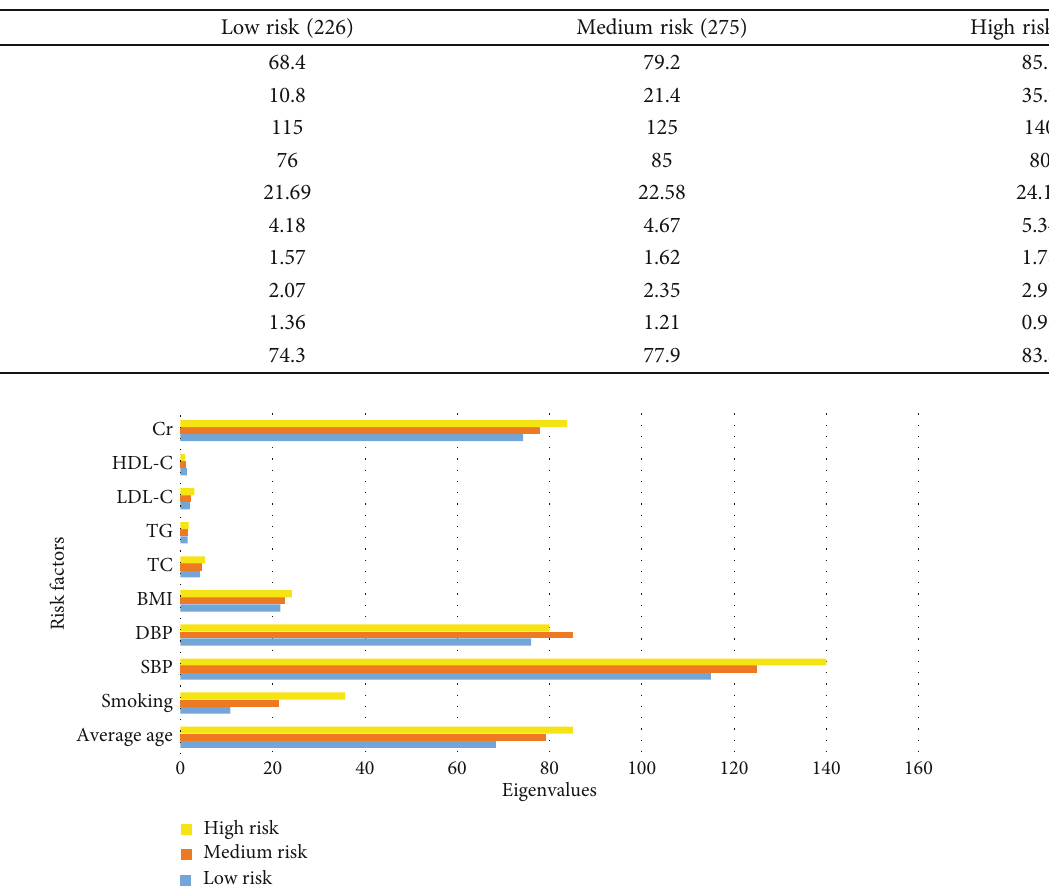
Figure 4: Comparison of baseline characteristic values of the three groups of patients.